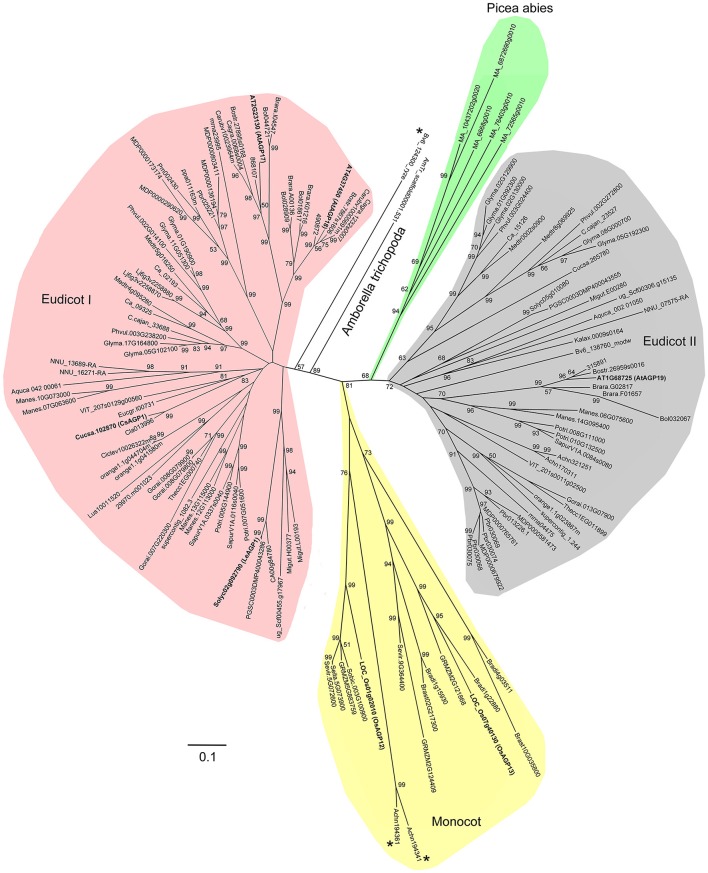
Phylogenetic relationship of Lys-rich AGPs. The phylogenetic tree is constructed based on the multiple sequence alignments of Lys-rich AGPs using MEGA 6.0. Bootstrapping is performed from 1000 reiterations of the neighbor-joining method. Scale bar represents 0.1 amino acid substitutions per site.